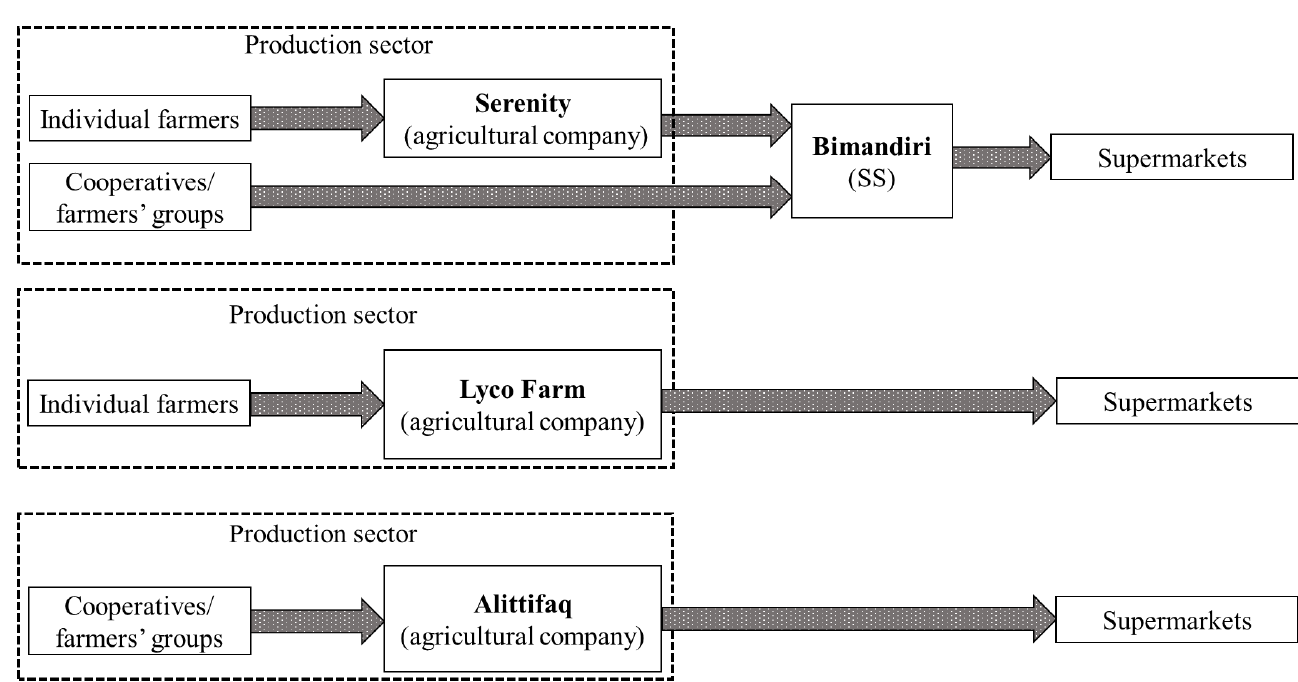
Figure 3. Current marketing channels of rural suppliers for supermarkets from authors’ survey.